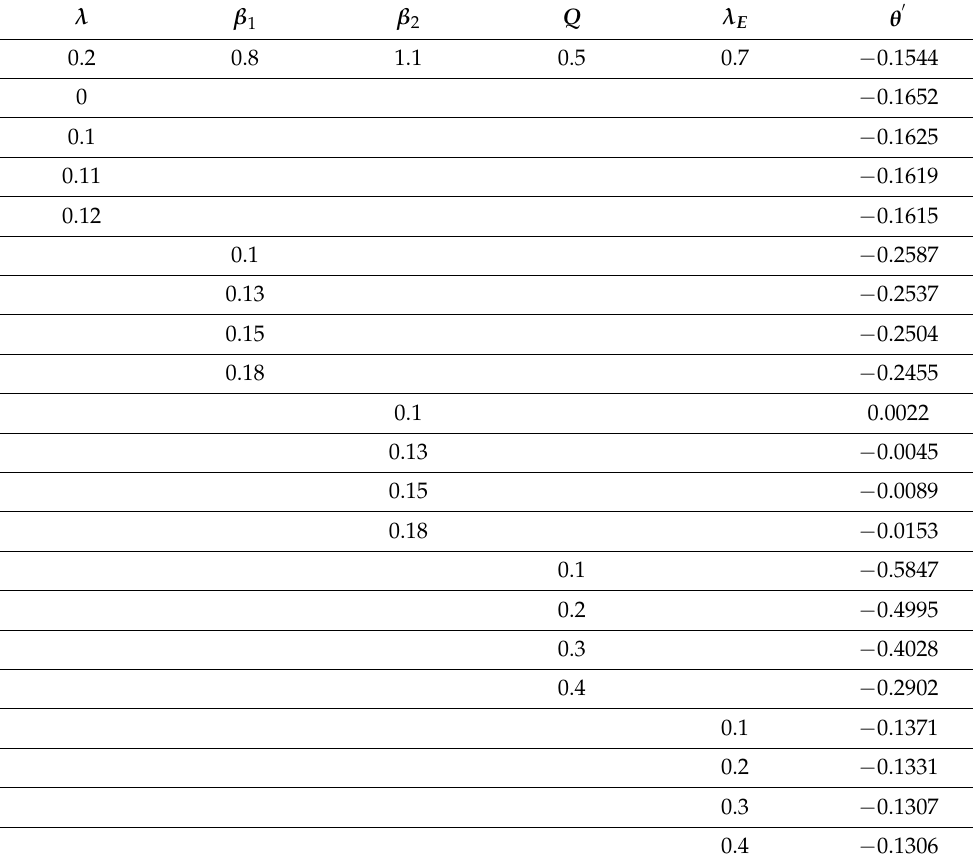
Table 4. The numerical values of θ (cid:48) with respect to pertinent varied